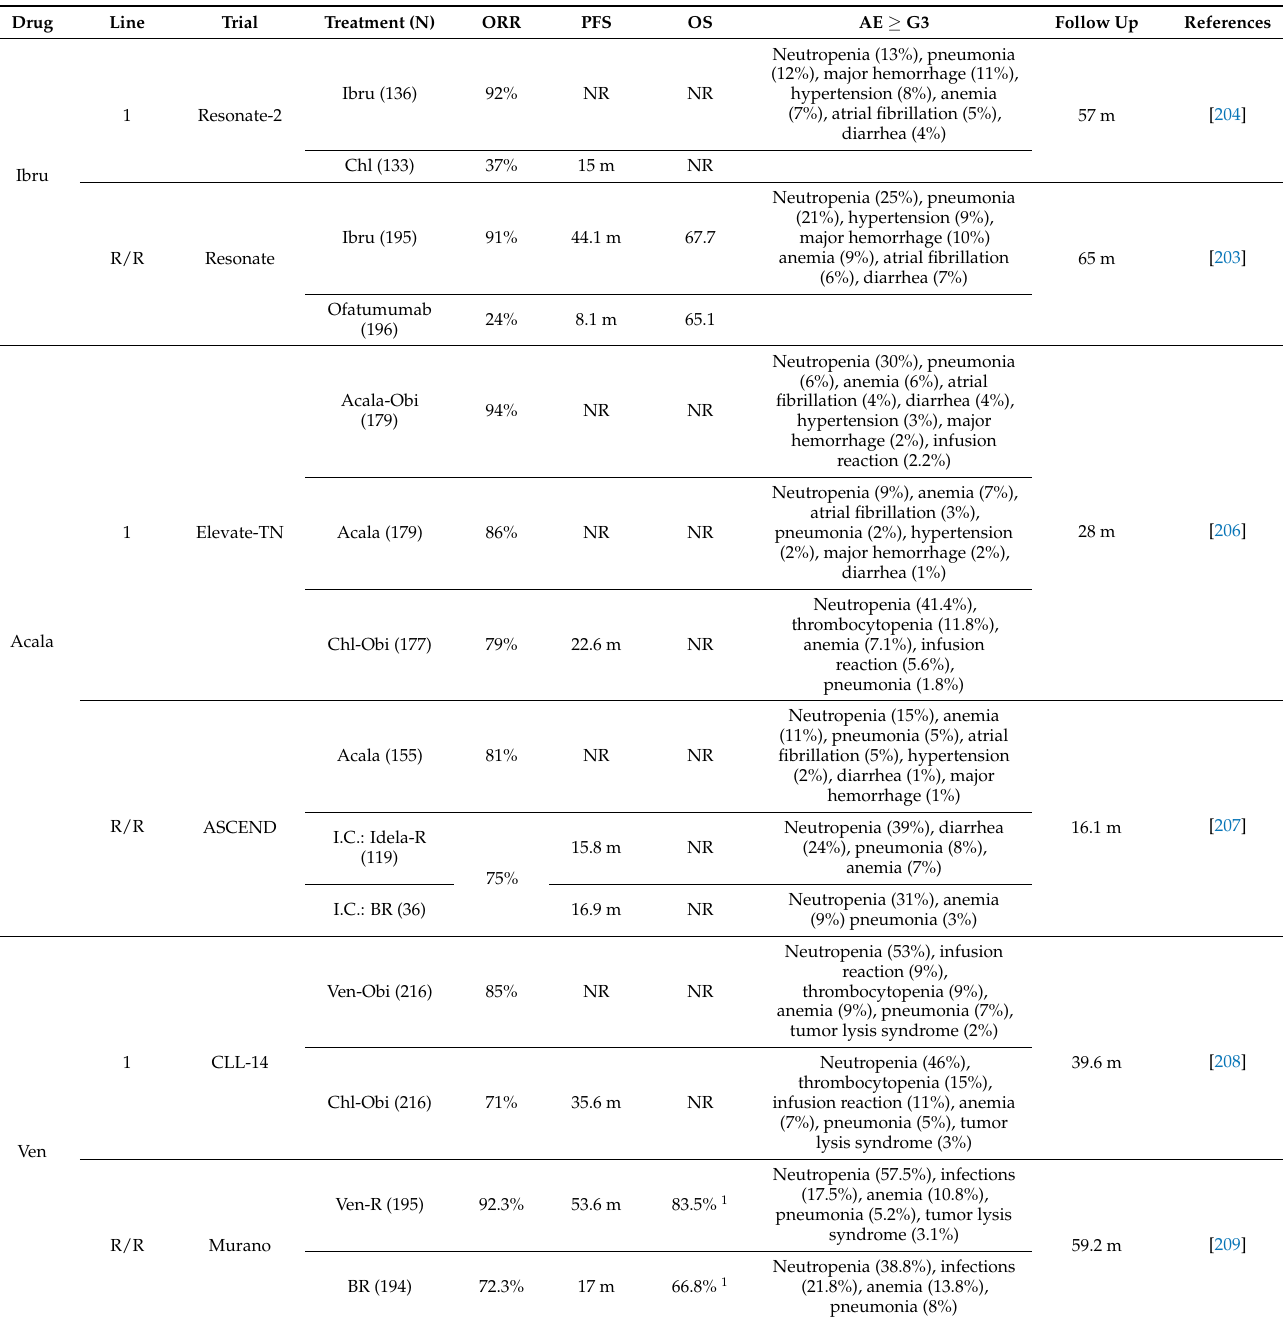
Table 2. Efficacy and safety of the most relevant new oral targeted therapy phase 3